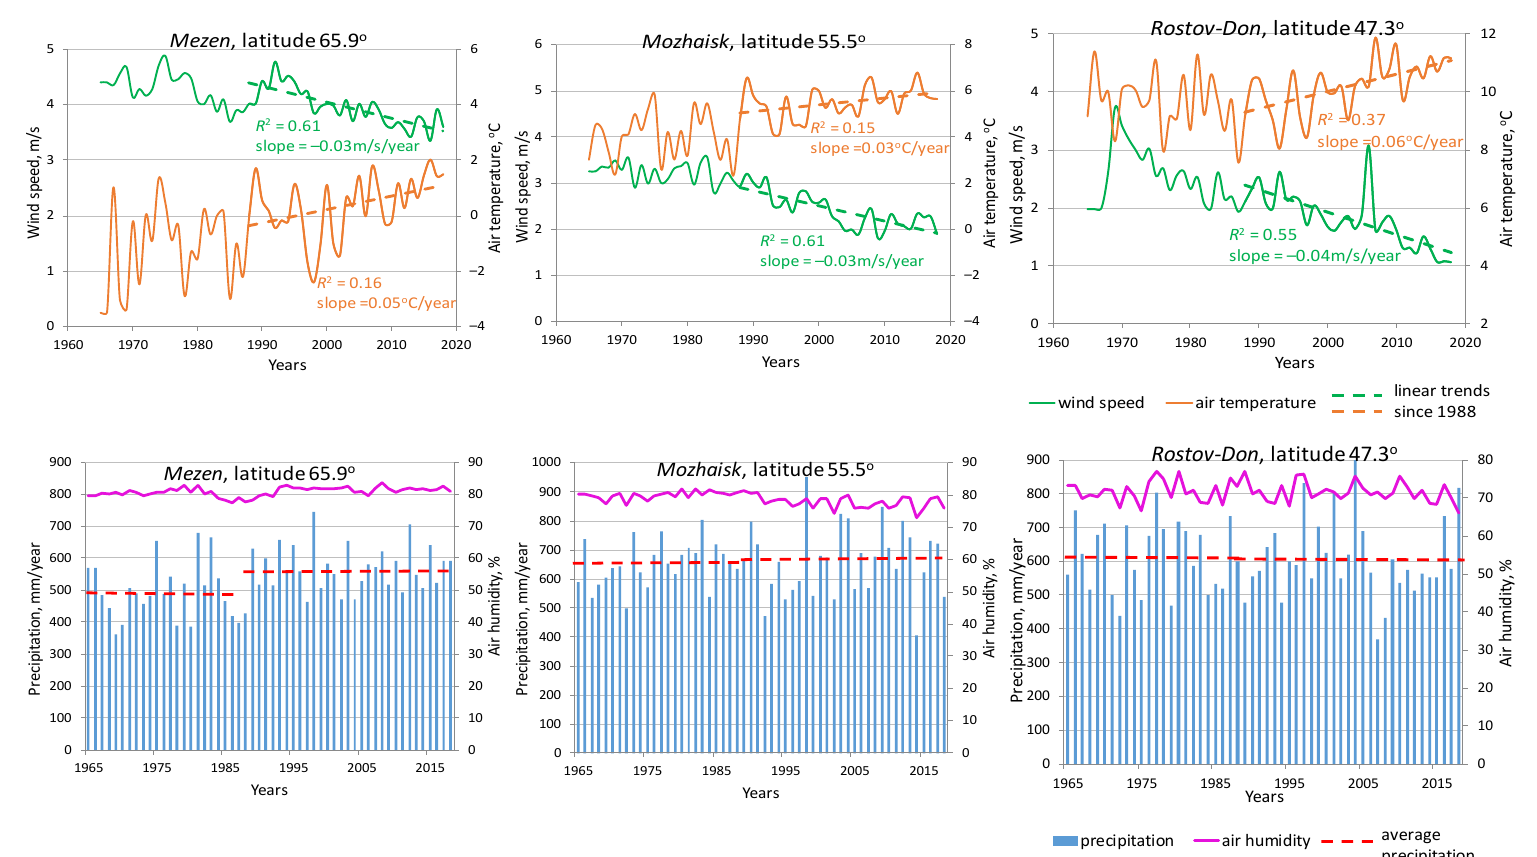
Figure 4. Average annual meteorological characteristics by weather stations at different latitudes for 1965 to 2018. Upper row: air temperature and wind speed with their linear trends; lower row: air humidity and precipitation. Red dushed lines - average precipitation for 1965–1988 and 1989–2018.